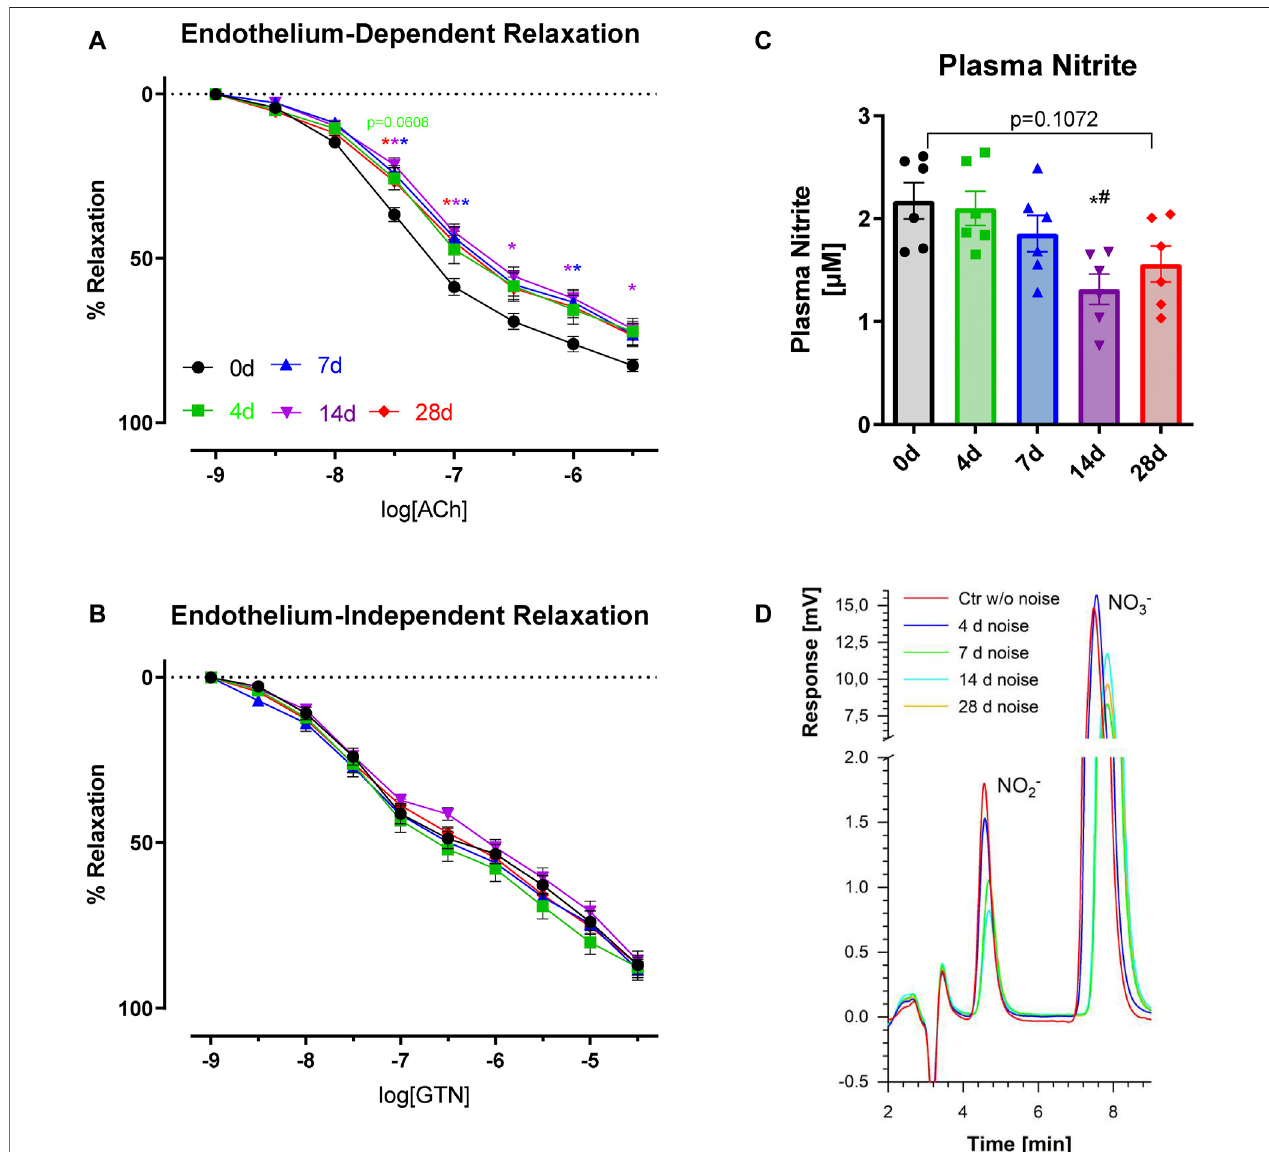
FIGURE2| Effectsoflong-termnoiseexposureonvascularNOformationandendothelium-dependentvasorelaxation. (A) Noiseimpairedendothelialfunctioninall groups studied to a similar degree. (B) Endothelium-independent vasorelaxation to the organic nitrate glyceryl trinitrate (GTN) was not impaired. (C) Levels of plasma nitritewerereducedafter14dofnoise. (D) RepresentativechromatogramsareshownfornitritedeterminationbyHPLC.Datapointsfor (A,B) arefromindividualanimals,n (cid:1) 16 – 20.Statisticalanalysiswith2-wayANOVAwithTukey ’ scorrection.Datapointsfor (C) arepooledplasmasamples,representingtwotofouranimalsperpoint.Statistical analysis with 1-way ANOVA with Tukey ’ s multiple comparison test. p < 0.05: * vs respective to 0d, # to 4d, $ to 7d, § to 14d and + to 28d.